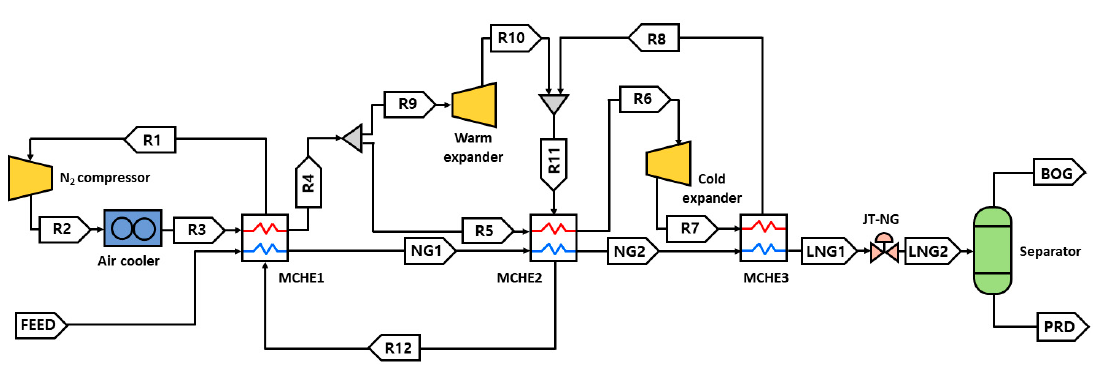
Figure 3. Process flow diagram of the dual nitrogen expansion system.